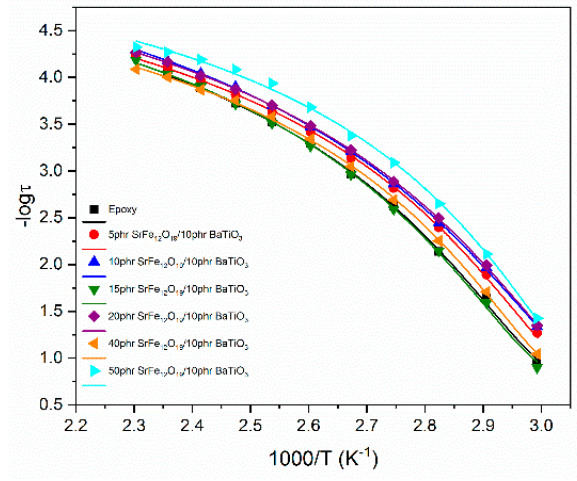
Figure 9. Relaxation time as a function of reciprocal temperature for α -relaxation process.